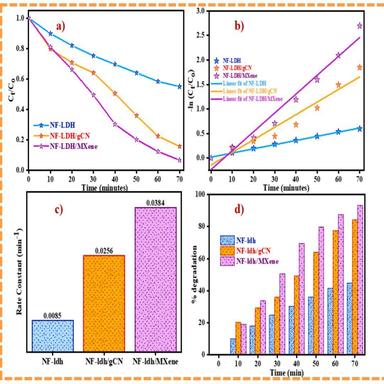
Kinetic studies of brexin in the presence of synthesized photocatalysts (a) Ceq/Ct versus time, (b) – ln (Ceq/Ct) versus time, (c) the values of rate constant (k), and (d) percentage degradation.